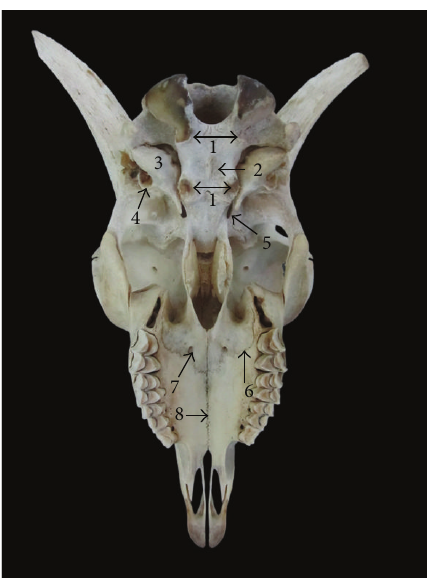
Figure 5: Ventral view of the skull of Markhoz goat showing 1: muscular tubercle, 2: sharp ridge on the basisphenoid, 3: tympanic bullae, 4: styloid process, 5: oval foramen, 6: transverse palatine suture, 7: greater palatine foramen, and 8: median palatine